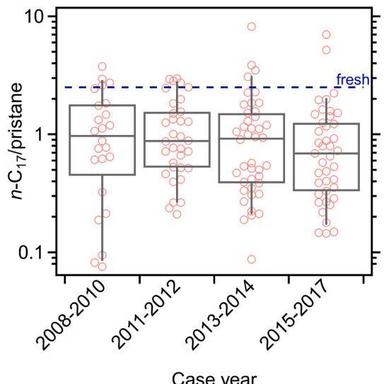
Box-and-whiskers plot of n-C17/pristane ratios versus binned reported case year for all samples with TPH concentrations greater than 10,000 μg/m3 . Boxes represent interquartile range (25th–75th percentile), with median as the center line, and whiskers showing the 10th and 90th percentiles. Ratio for fresh home heating shown as dashed line. Data shown log-transformed for clarity. Differences between bins were found to be not statistically significant using a Kruskal-Wallis test, tested in both log and linea